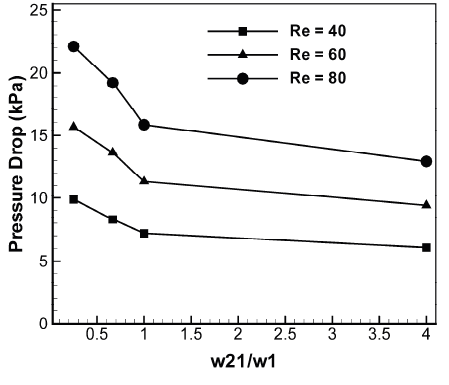
Figure 14. Effect of sub-channel width on the pressure drop for various Reynolds